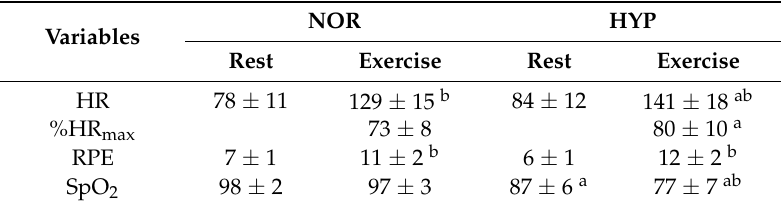
Table 1. Physiological responses to moderate intensity exercise in normoxia or hypoxia. Variables